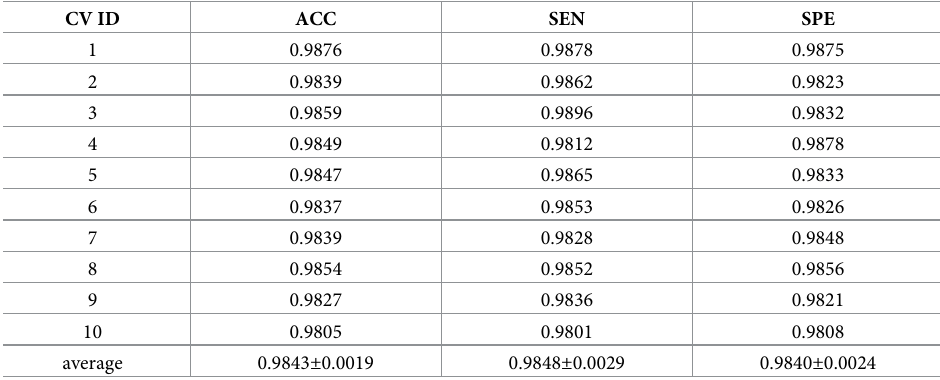
Table 2. Performance of ten-fold cross validation at yellow star point in Fig 5.